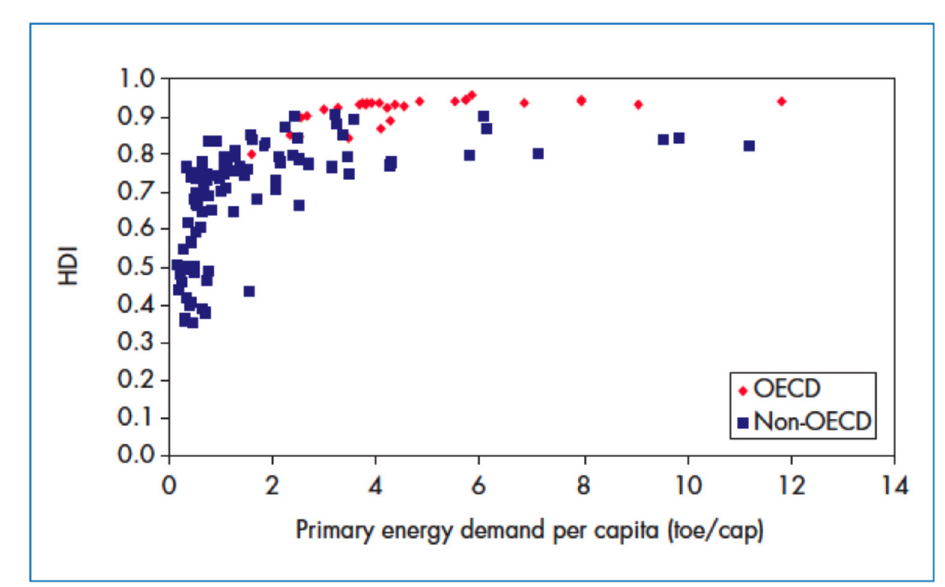
Fig. 1. – HDI and primary energy demand per capita, 2002. (Courtesy of IEA.)